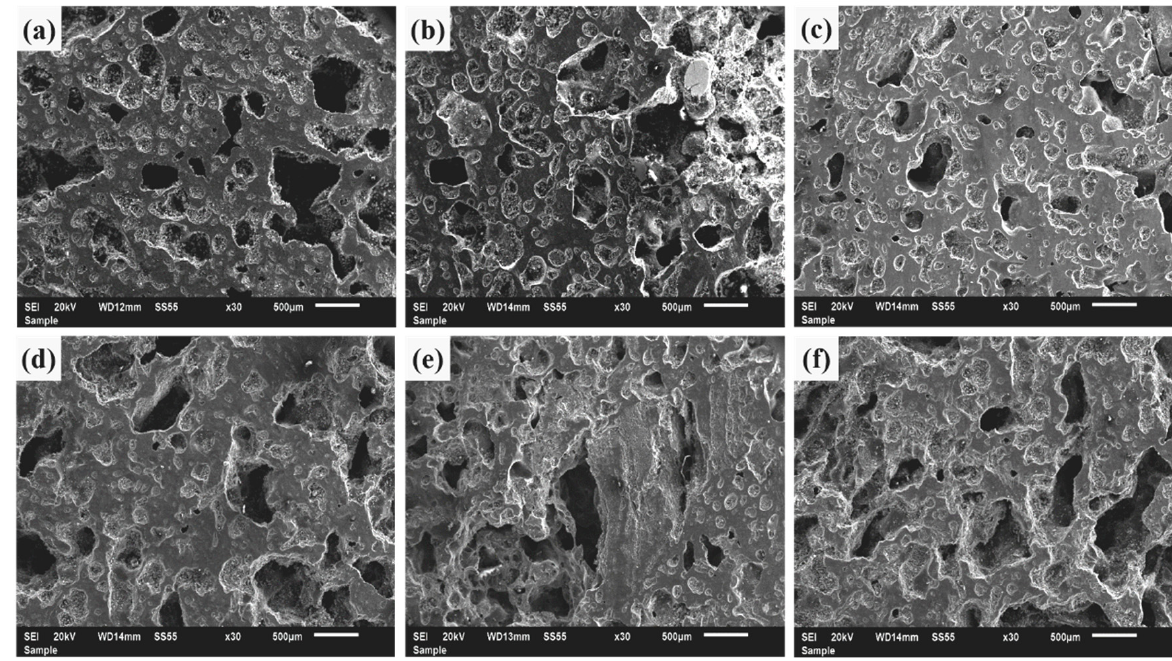
Figure 9. Micro morphology of IC and TC in different radial directions of the tuyere plane. ( a ) IC; ( b ) TC: 0–0.5 m; ( c ) TC: 1–1.5 m; ( d ) TC: 2–2.5 m; ( e ) TC: 3–3.5 m; ( f ) TC: 4–4.5 m.